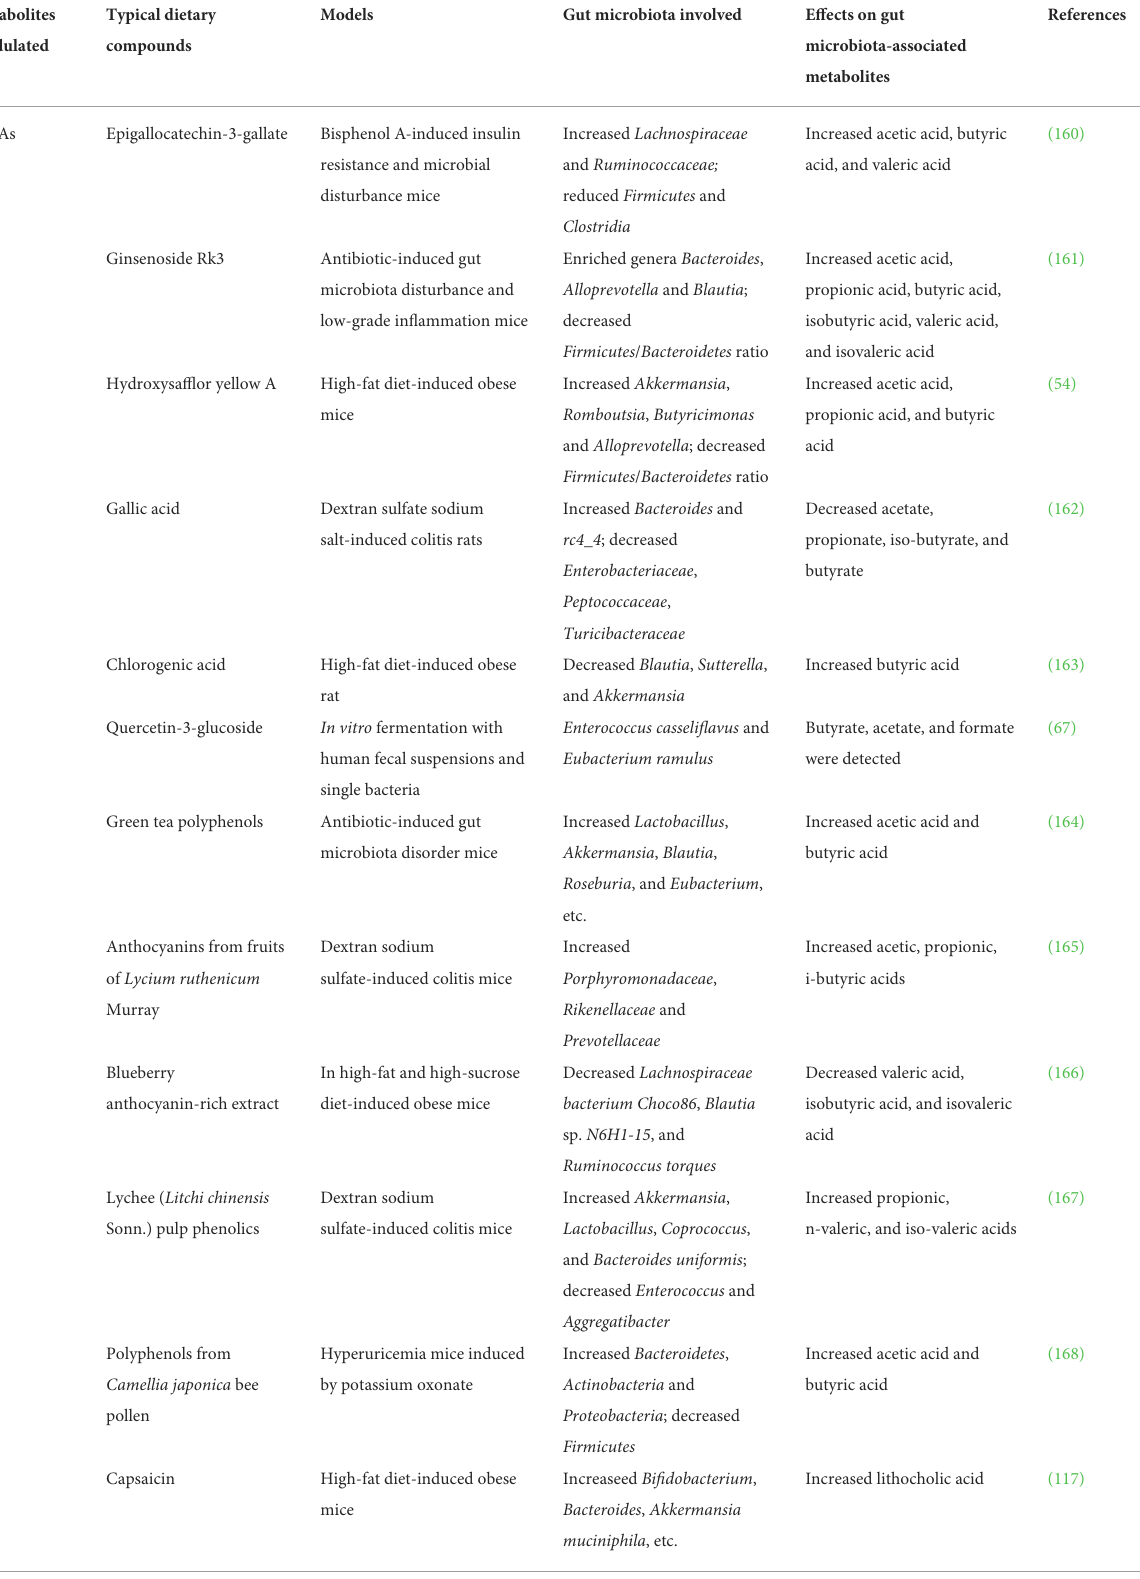
TABLE 3 Non-polysaccharide dietary compounds and extracts in modulation of typical gut microbiota-derived